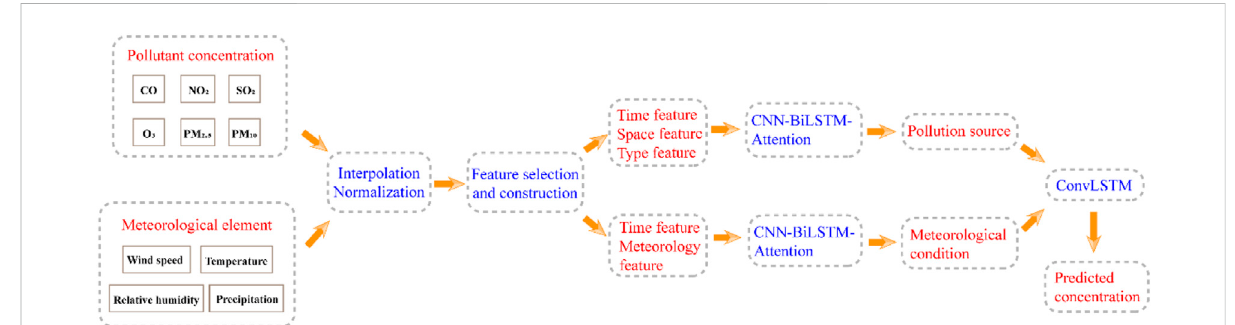
FIGURE 6 The architecture of TSTM.